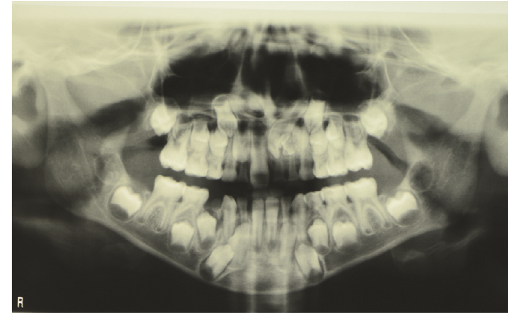
Figure 2: OPT of the patient with supernumerary dental